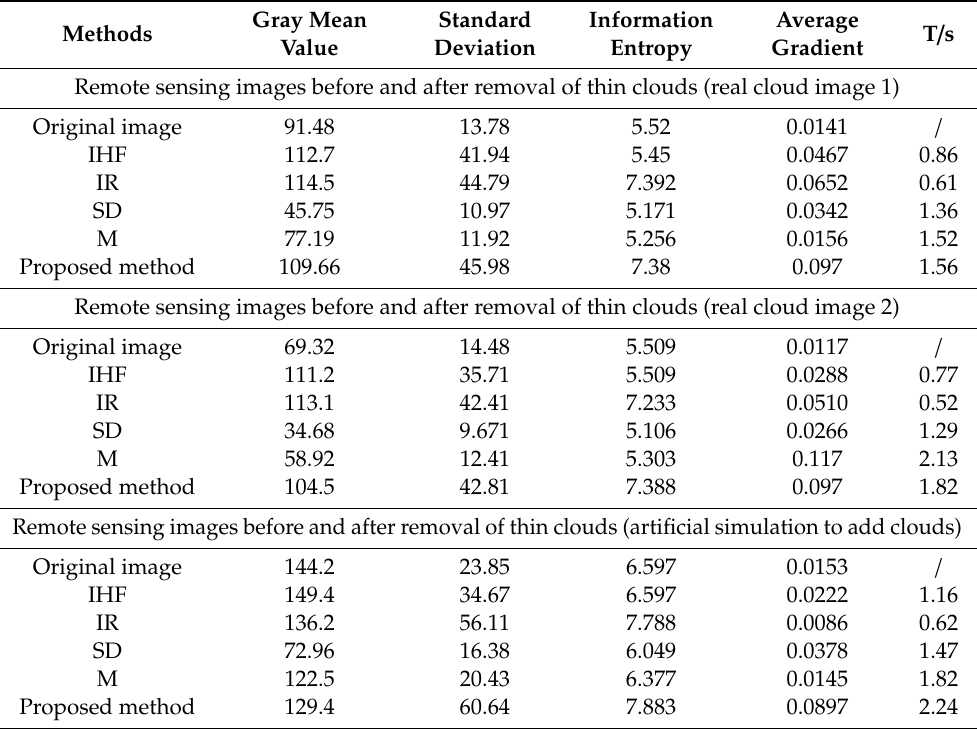
Table 1. Objective evaluation indicators of remote sensing images before and after thin cloud